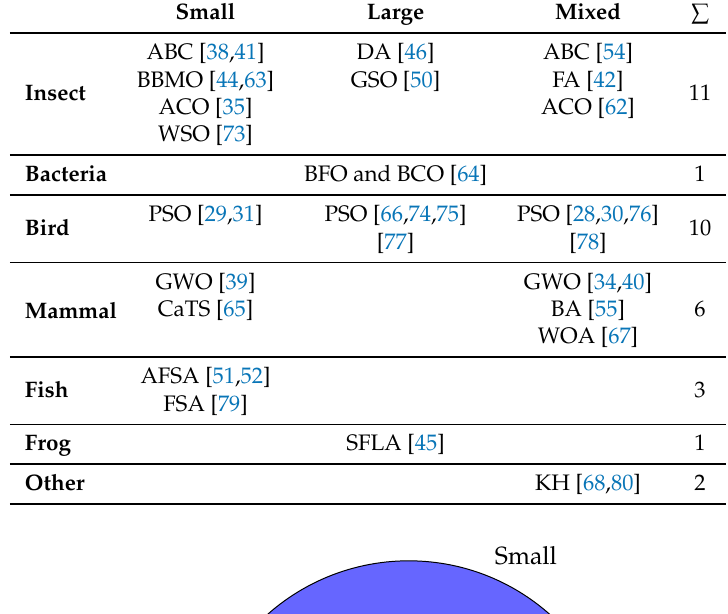
Table 2. Used dataset sizes in evaluating swarm intelligence (SI) for feature selection (FS).